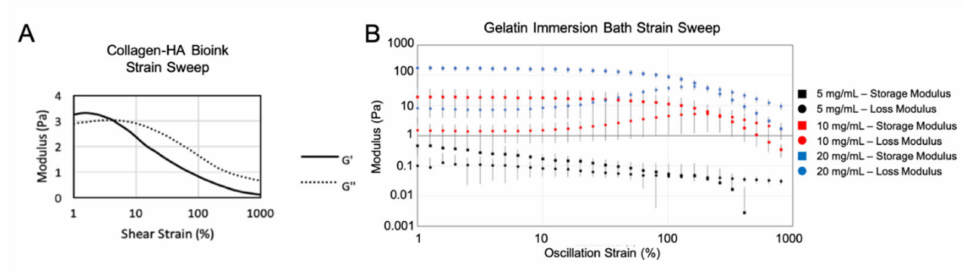
Figure 3. Rheological assessment of collagen–HA bioink versus gelatin bath solution. Storage and loss moduli data resulting from strain sweep tests from 1% to 1000% shear strain ( γ ) for ( A ) the collagen–HA bioink and ( B ) gelatin solutions (5, 10, and 20 mg /